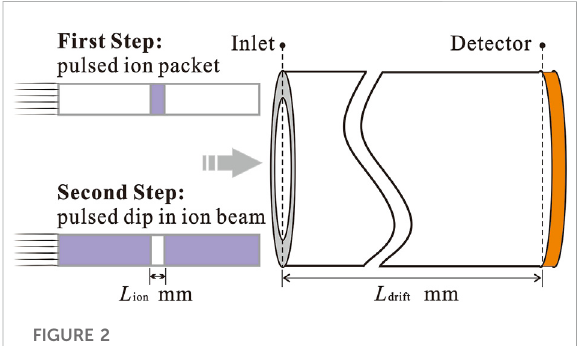
FIGURE 2 Schematic indicating the parameters of the drift tube.